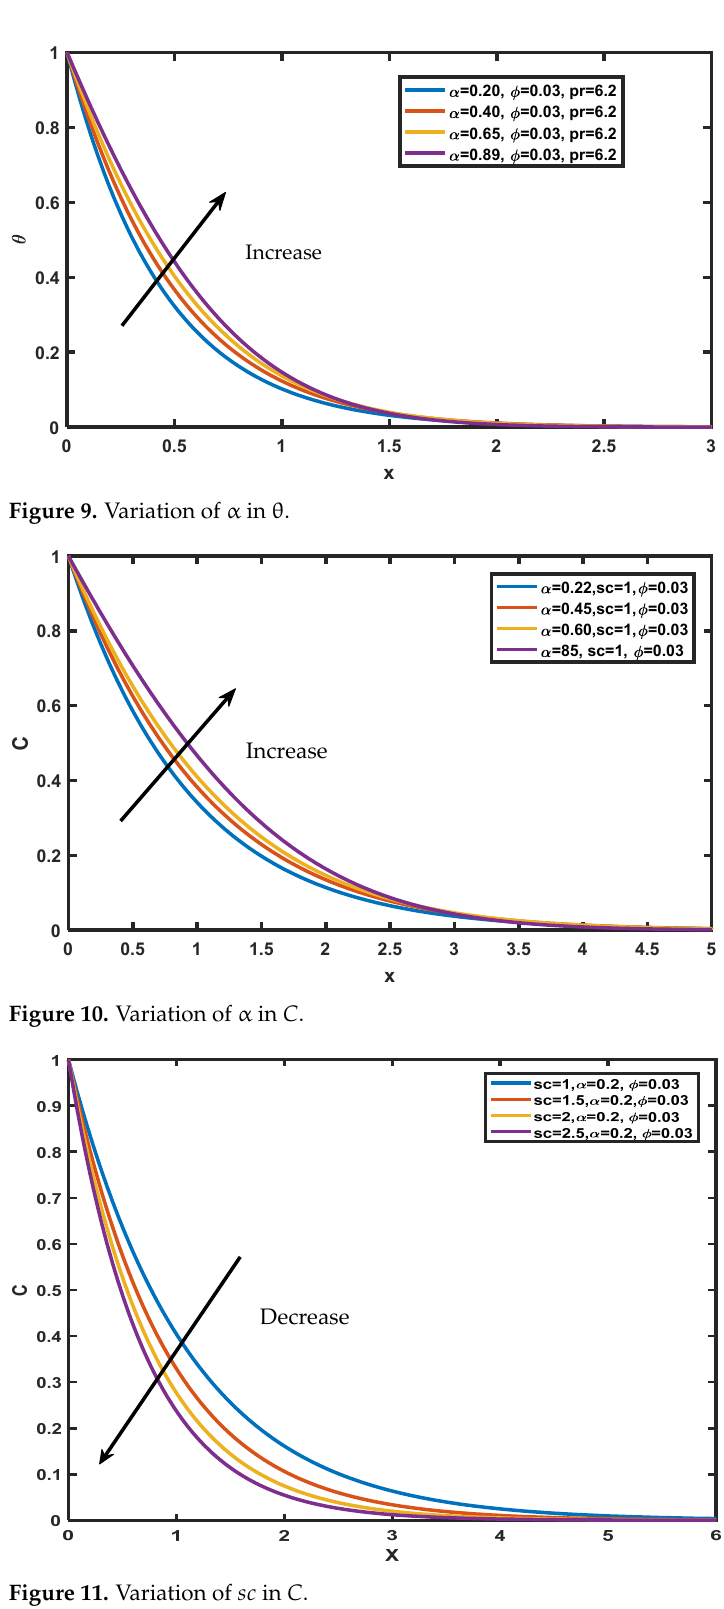
Figure 11. Variation of sc in C .